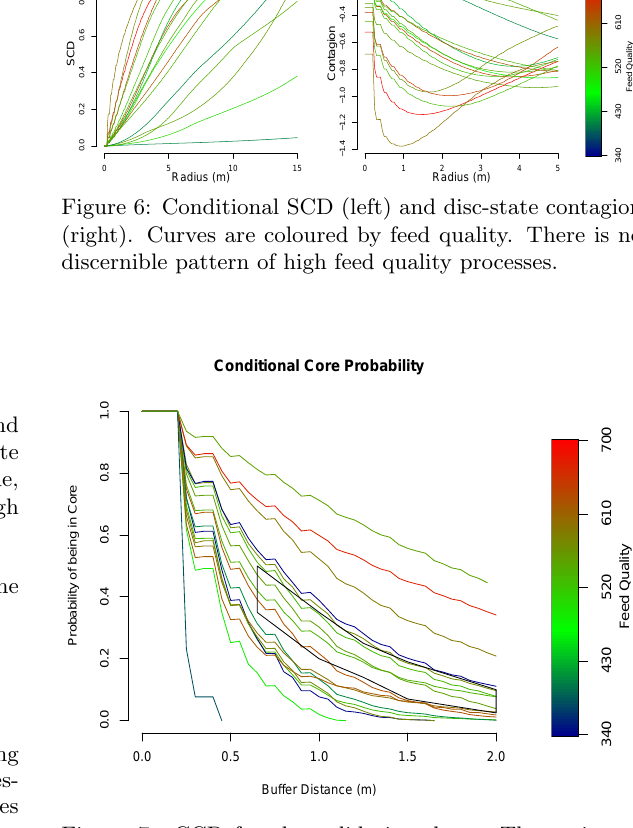
Figure 7: CCP for the validation data. The region of high feed process observed in the exploration data is shown (black polygon). The separation did not generalise to the validation data.